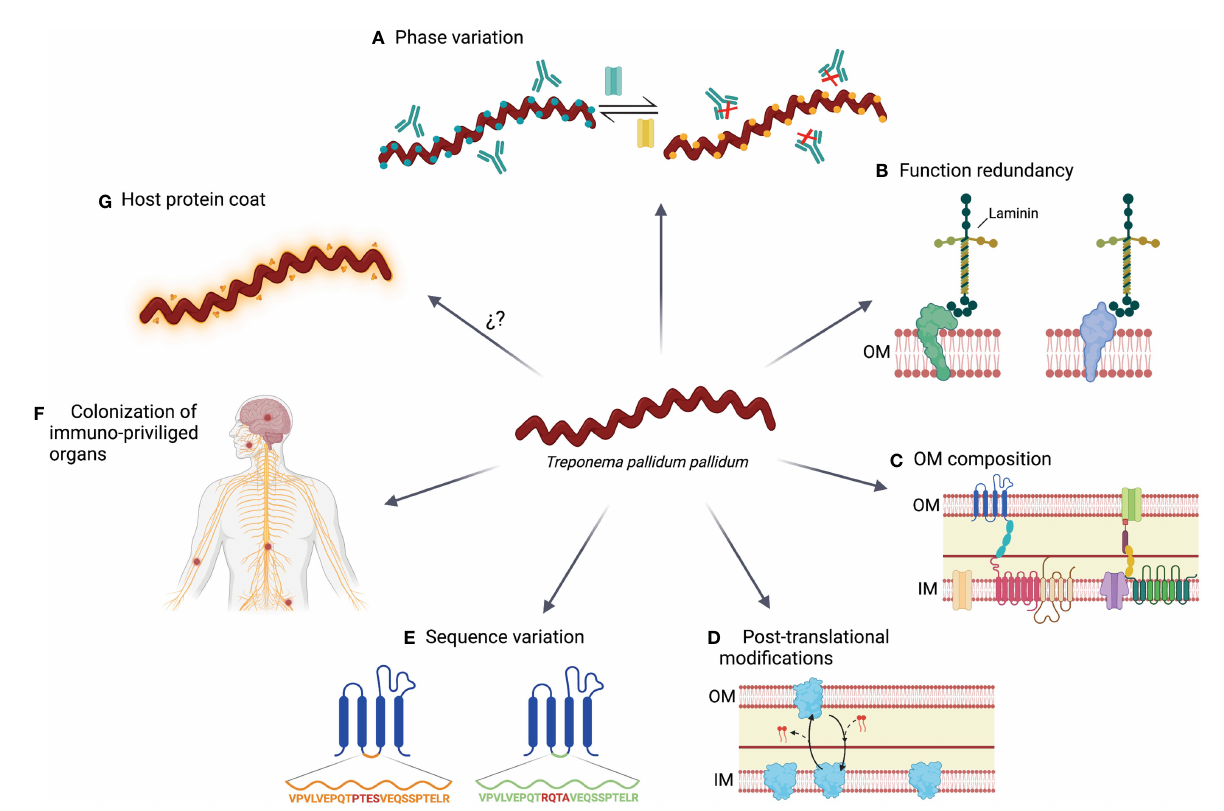
FIGURE 2 Immune evasions mechanisms use by TPA. (A) During its adaptation to environment changes, including the immune system pressure, TPA modulates the expression of certain genes by a switch on/off mechanism. (B) Linked with the prior mechanism; function redundancy ensure that bacterial homeostasis is not compromised by changing the expression of proteins with vital functions. (C) OM of TPA is characterized by a paucity of protein compare with the inner membrane (IM), the lack of LPS and the presence of anti-in fl ammatory phospholipids (i.e., phosphatidylserine and phosphatidylcholine). (D) Some proteins experience post-translational modi fi cations that result in variants with different location preference. (E) Proteins can accumulate sequence variations by point mutation, gene conversion or recombination. (F) TPA can persist in immune privileged organs, such as central nervous system or nerve fi bers, and prolong their survival by remaining hidden to the immune system. (G) TPA may be coated by host serum proteins, reducing its